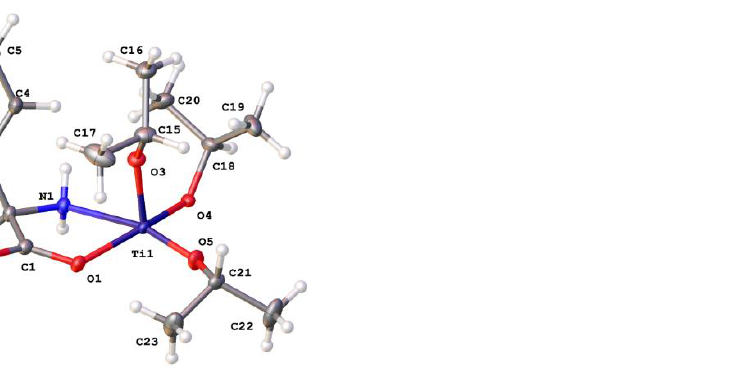
Figure 8. Asymmetric unit of 8 with atoms drawn as 50% probability ellipsoids. For clarity, minor disorder is not shown. Selected bond lengths (Å) and bond angles ( o ): Ti(1)-Ti(1 i ) 3.2788(4), Ti(1)-